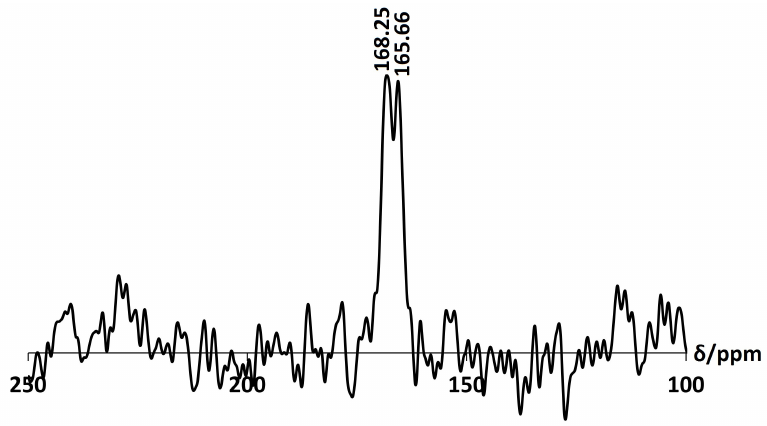
Figure 10. PXRD pattern for Ca-A. The characteristic calcite peak is identified.